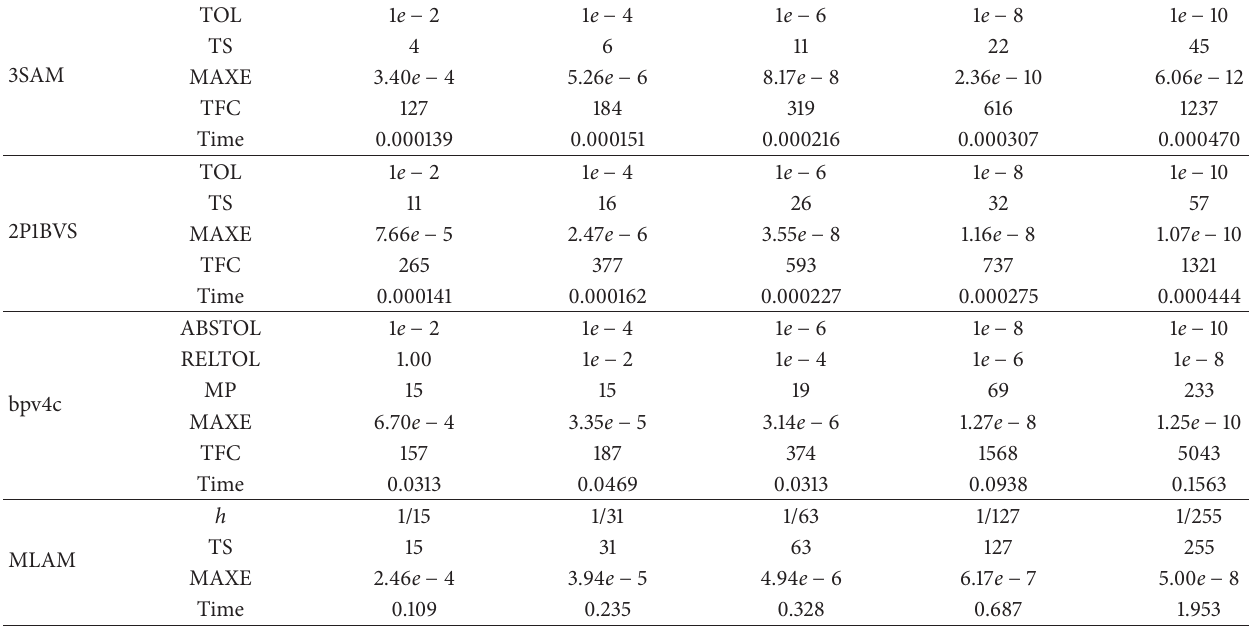
Table 1: Comparison of the numerical result for solving Problem 1.